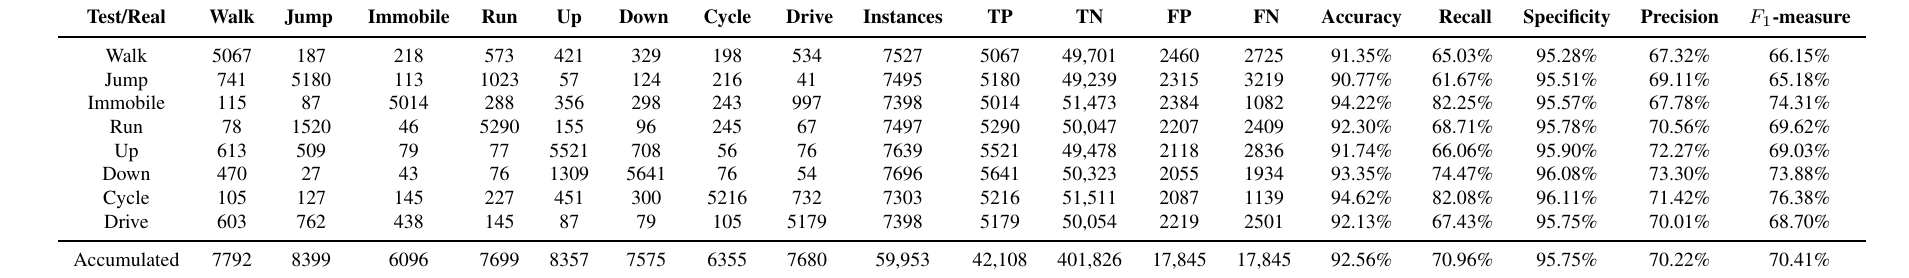
Table B4. Confusion matrix and performance values for the Bayesian-based classification system.